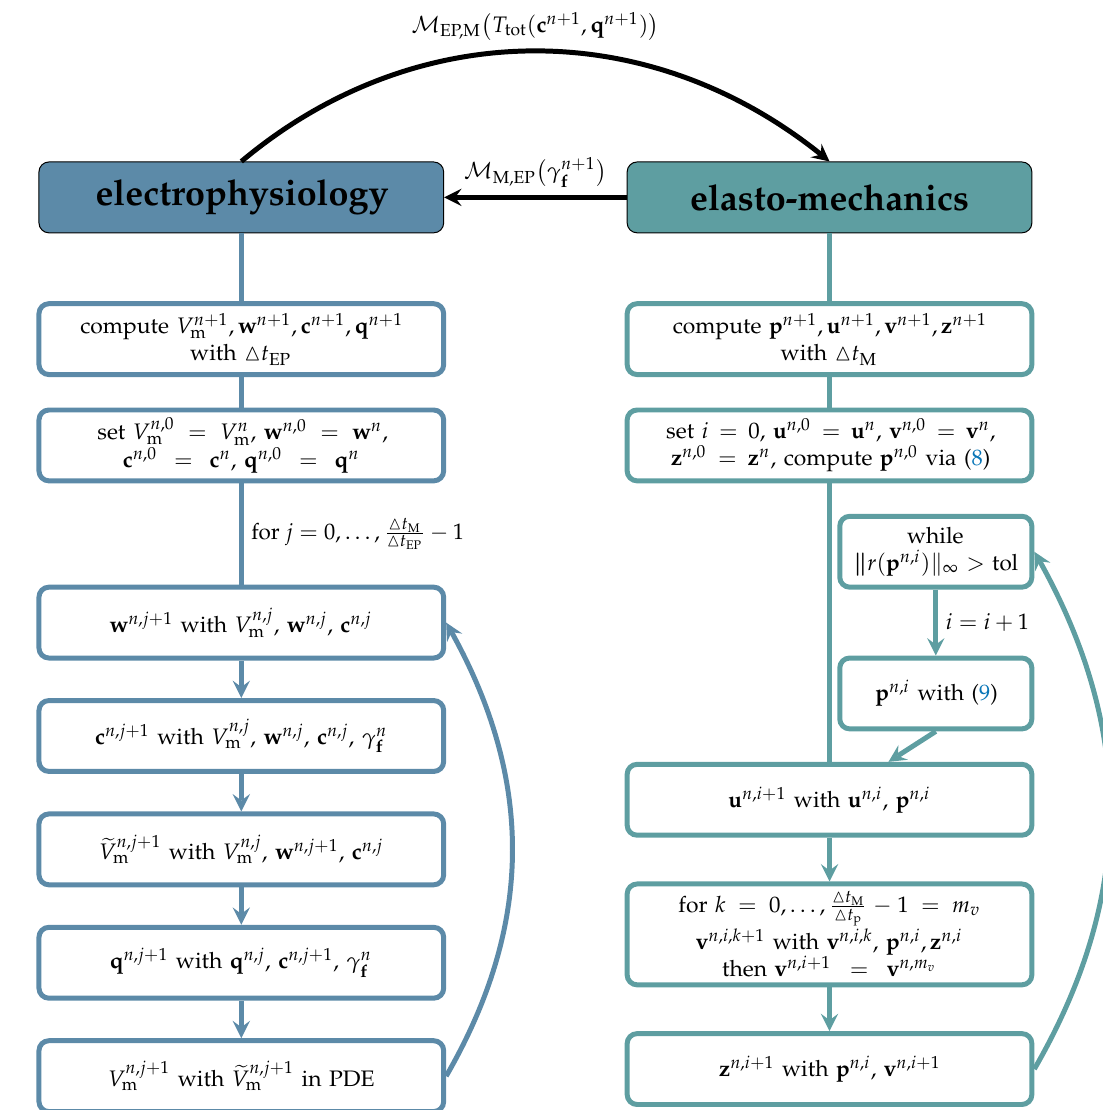
Figure 3. Staggered algorithm for the fully coupled problem at time steps t n + 1 = ( n + 1 ) (cid:77) t M evaluating the solutions at t n = n (cid:77) t M with different time step sizes (cid:77) t M = 0.001s, (cid:77) t EP = 0.00001s and (cid:77) t p = 0.0001s for n > 5 and tol = 10 − 7